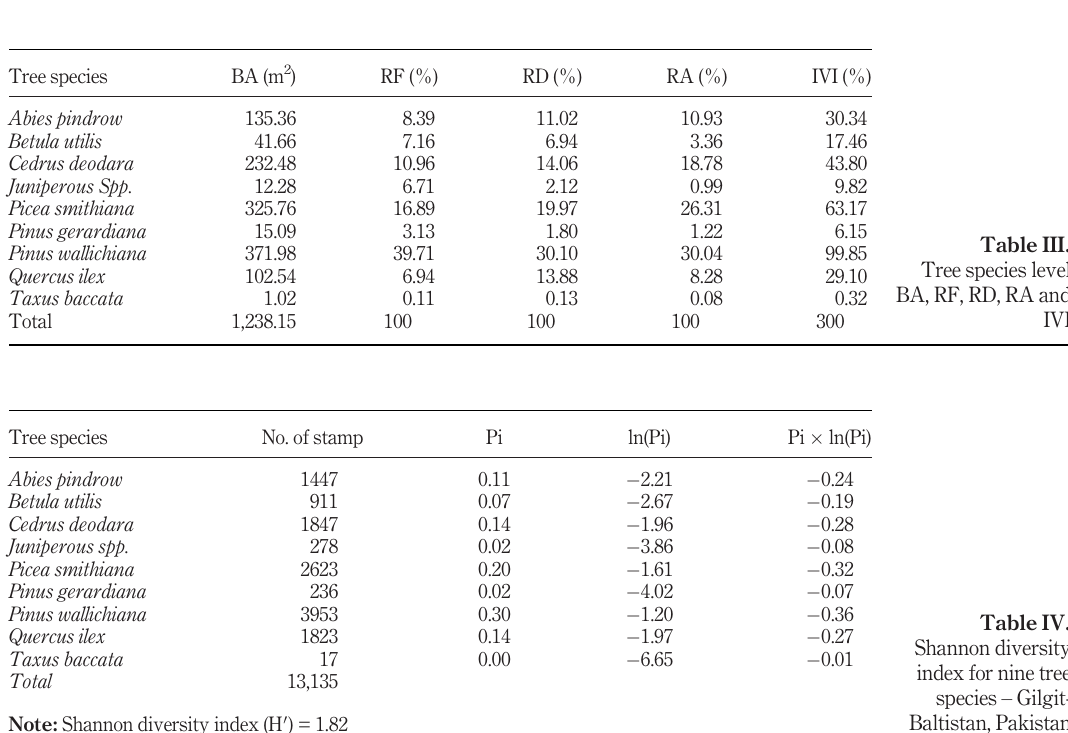
Shannon diversity index for nine